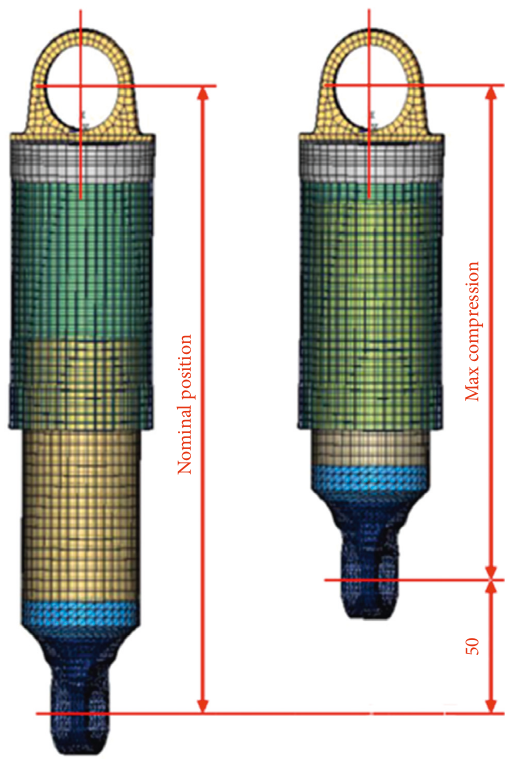
Figure 22: Shock absorber stroke.